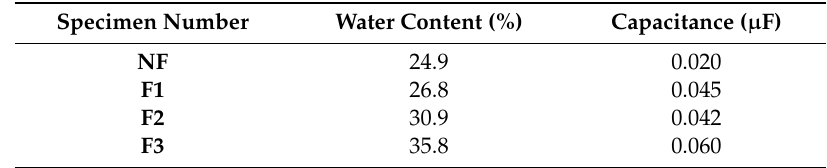
Table 4. Water content and capacitance of IPMC specimens according to the foaming conditions for Nafion.